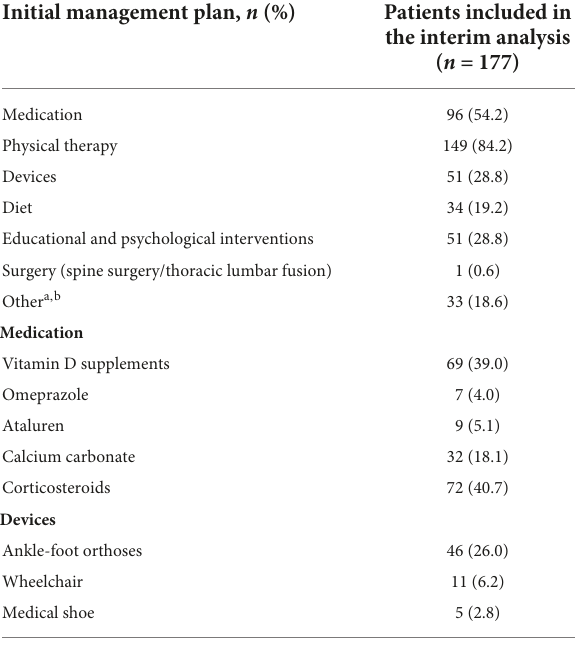
TABLE 2 Initial patient management plans a